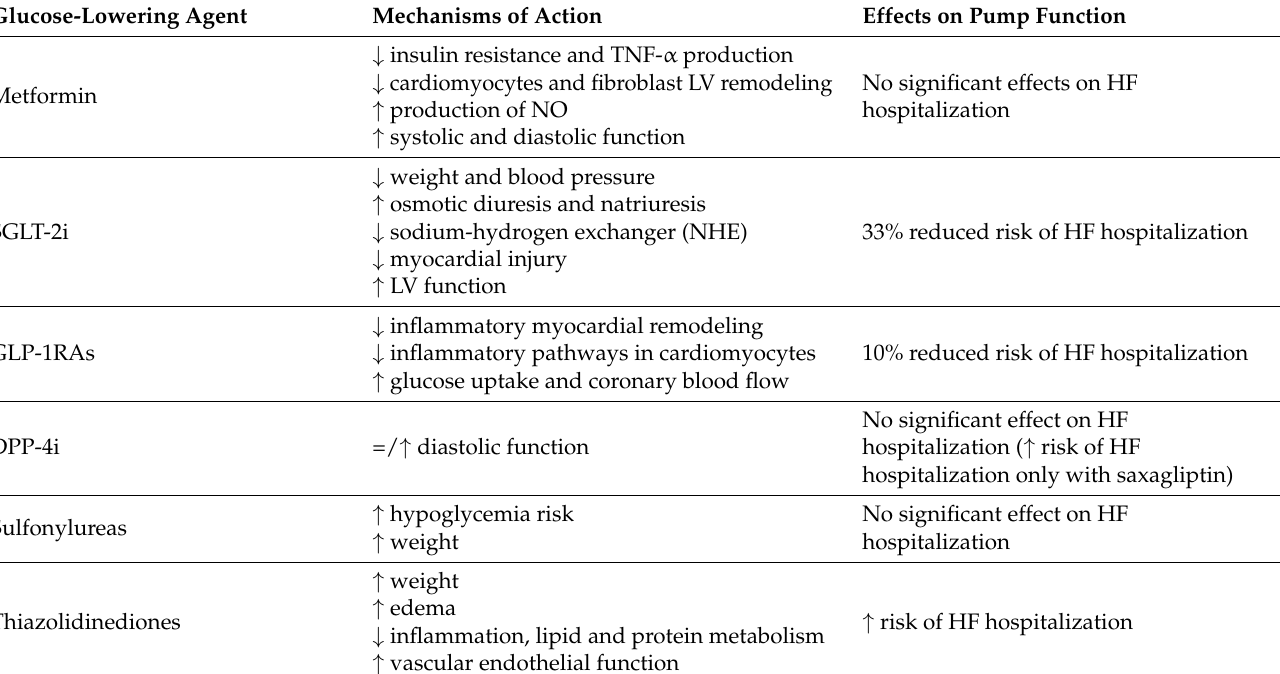
Table 2. Summary of the main effects of different glucose-lowering agents on diabetic cardiomyopathy and heart